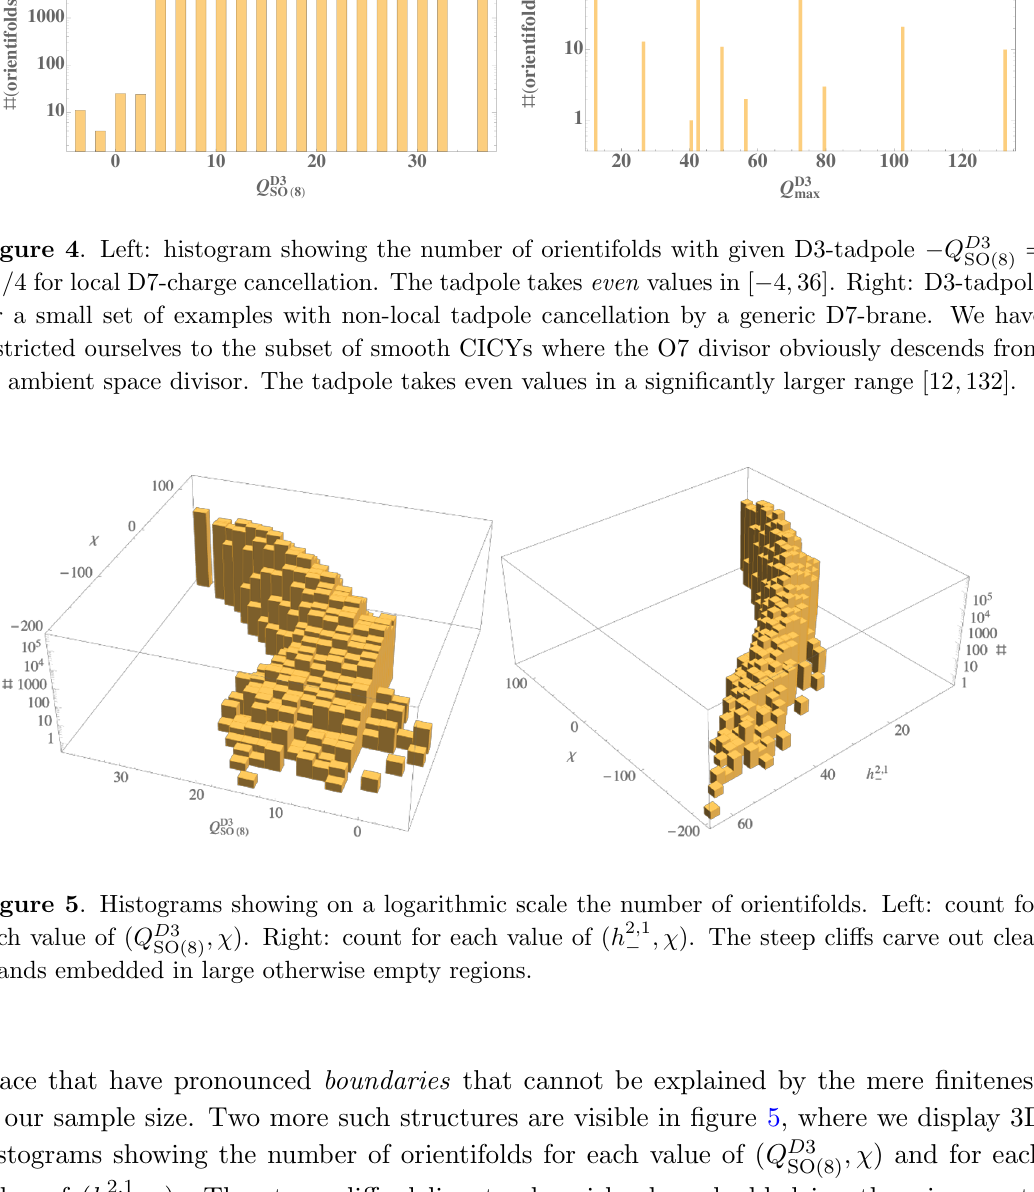
; (cid:31) ). The steep cli(cid:11)s carve out clear (cid:0)